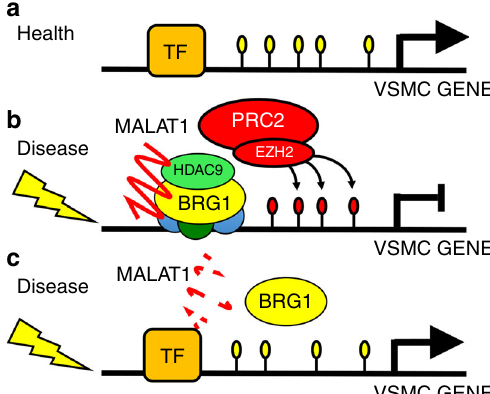
Fig. 8 Disease induced transcriptional repression by the HDAC9 – BRG1 – MALAT1 complex. a In the healthy aorta, genes responsible for normal aortic homeostasis are transcribed by multiple transcription factors (TF) such as MEF2, Myocardin, and Myocardin-related transcription factors (MRTFs). b Disease processes activate assembly of the HDAC9 – BRG1 – MALAT1 complex. The promoters of target genes are silenced through the action of the complex and the acquisition of histone 3 lysine 27 trimethylation through polycomb repressive complex 2 (PRC2). c Reduced dosage of MALAT1 and/or HDAC9 causes destabilization of the complex and allows for expression of silenced gene loci and reversal